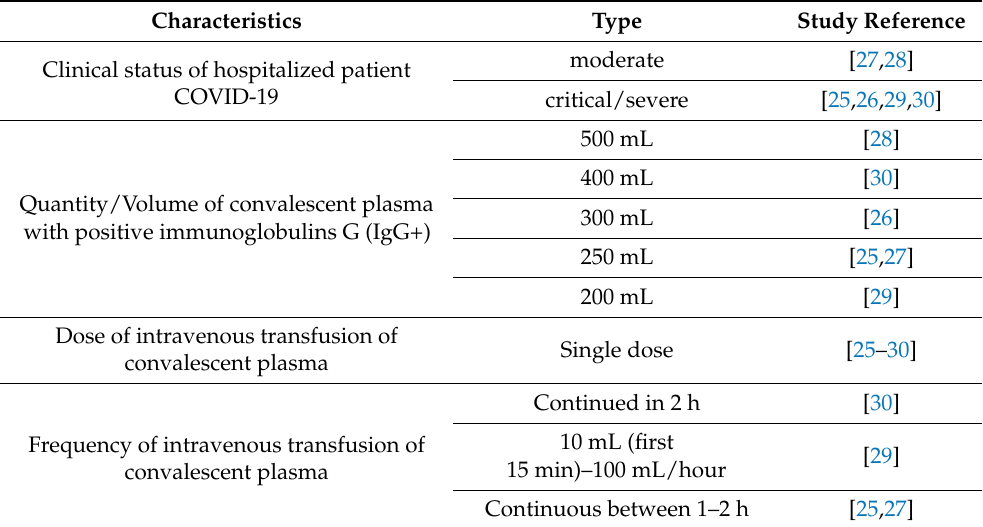
Table 2. Descriptive synthesis of the studies included in the systematic